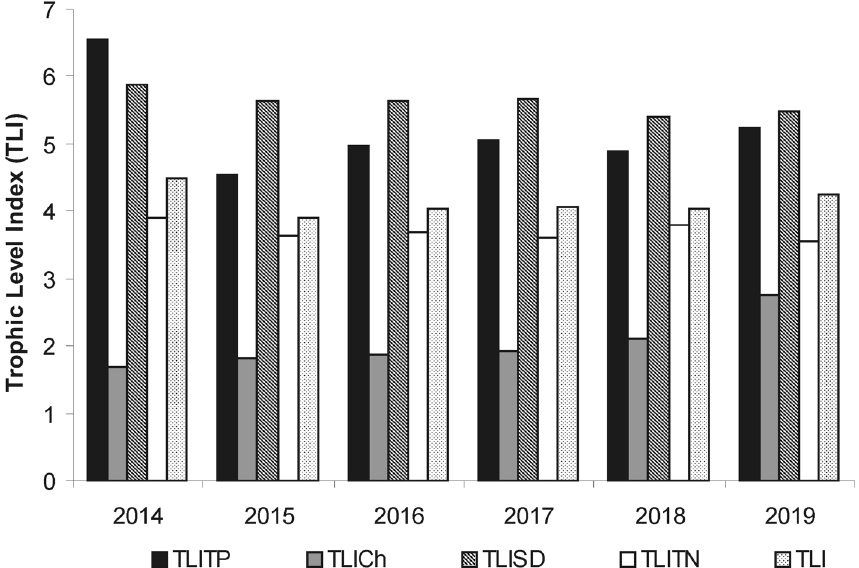
Figure 1. Trophic Level Index (TLI) and its partial indices based on TP (TLITP), TN (TLITN), SDD (TLISDD) and Chl a (TLICh) (averages from the growth season); trophic classification: 0–1, 1–2, 2–3, 3–4, 4–5, 5–6, 6–7 for ultra-microtrophic, microtrophic, oligotrophic, mesotrophic, eutrophic, supertrophic and hypertrophic,